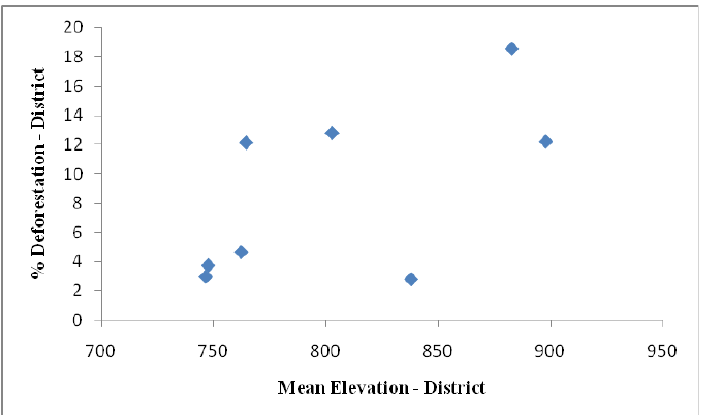
Figure 9a. Relationship between mean elevation and the distribution of deforestation for